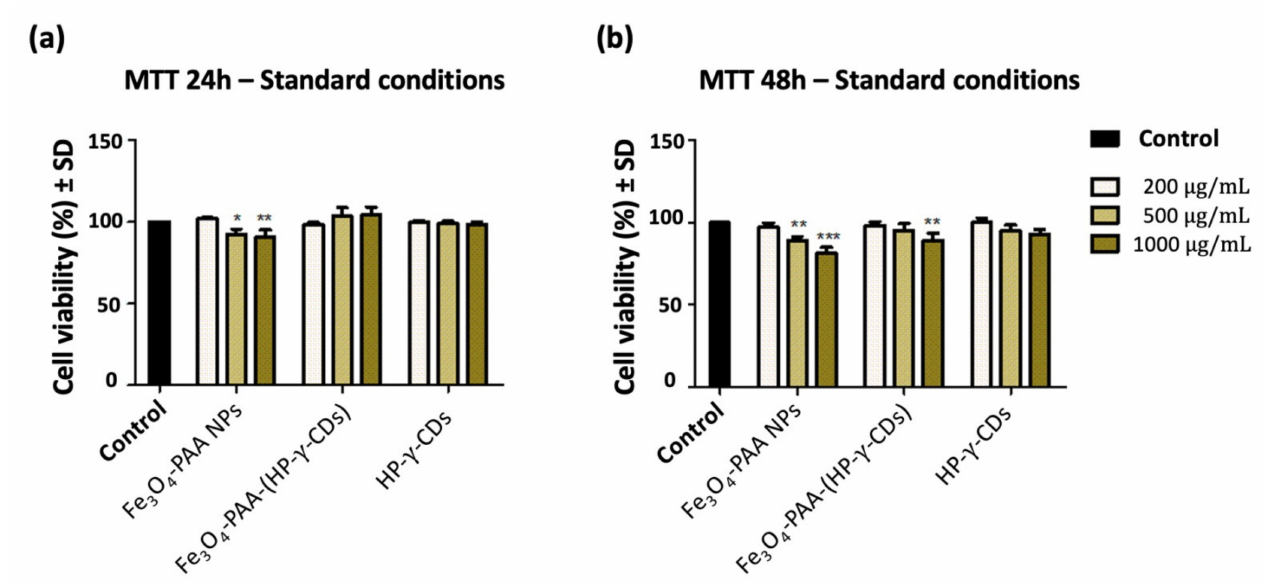
Figure 13. Cell viability percentage of immortalized human keratinocytes (HaCaT) exposed to test samples at different concentrations (200, 500, and 1000 µ g/mL): ( a ) Cell viability at 24 h post- stimulation; ( b ) cell viability at 48 h post-stimulation. The results are expressed as the mean values of the cell viability percentage (%) normalized to control cells (cells treated with culture media) ± stan- dard deviation (SD). One-way ANOVA analysis was applied to determine the statistical differences between test-treated cells and control, followed by Dunnett’s post-test (* p < 0.05; ** p < 0.01; *** p < 0.001 versus